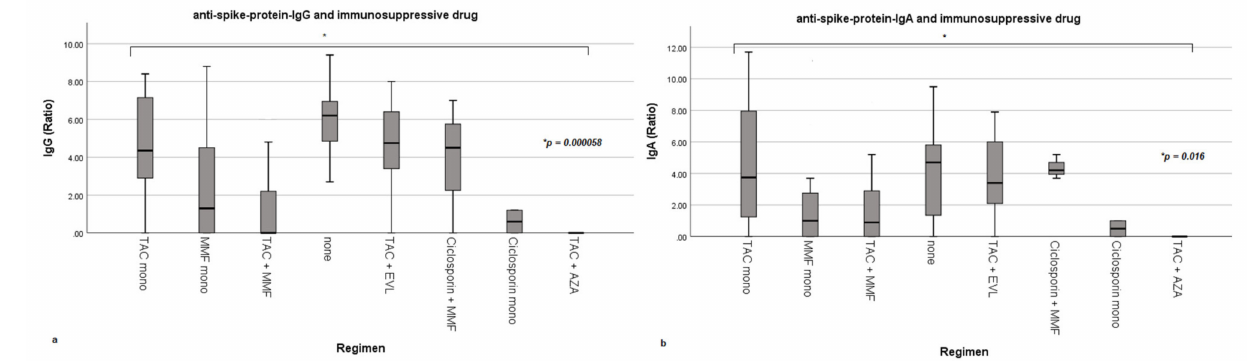
Figure 2. Influence of immunosuppressive drugs on anti-spike-protein-IgG- and IgA-levels as box plots. ( a , b ) show the influence of the immunosuppressive regimen on anti-spike-protein-IgG and IgA-levels. MMF = mycophenolate mofetil; TAC = tacrolimus, EVL = everolimus; AZA = azathioprine. Ratio = dimensionless unit; quotient of the extinction value of the patient sample and the calibrator. Box plots present means, interquartile range (IQR), minimum and maximum with each individual